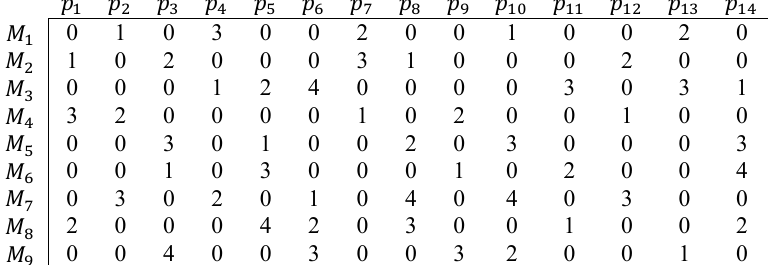
Displacement of machines